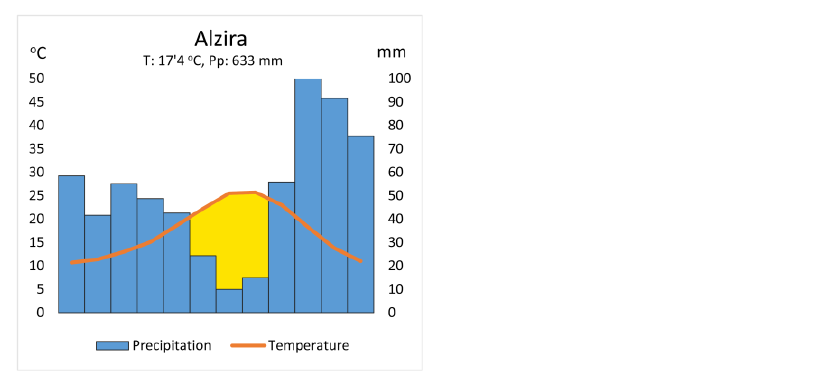
Figure 8. Gaussen diagram for Alzira station. Source: Prepared by author based on [55].